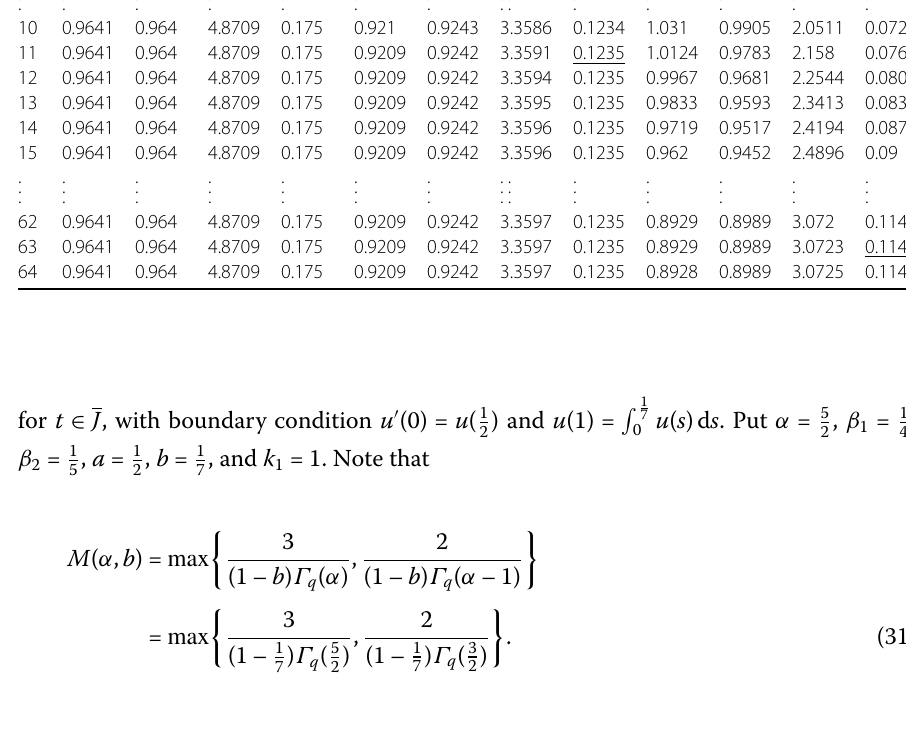
Table 7 Some numerical results of τ ( α , b ) < 1 in equation (29) in Example 1 for q = 1